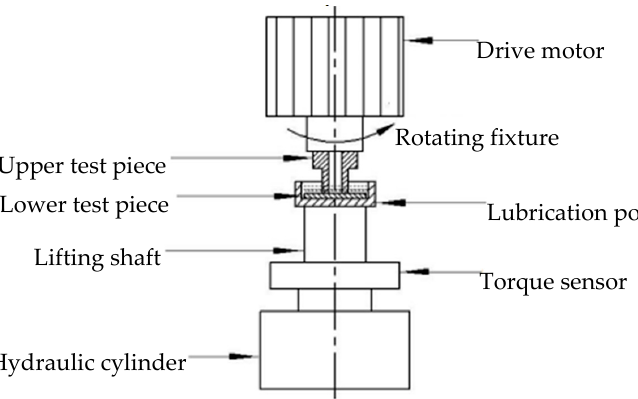
Figure 7. Schematic diagram of MMG-10 friction and wear test machine.